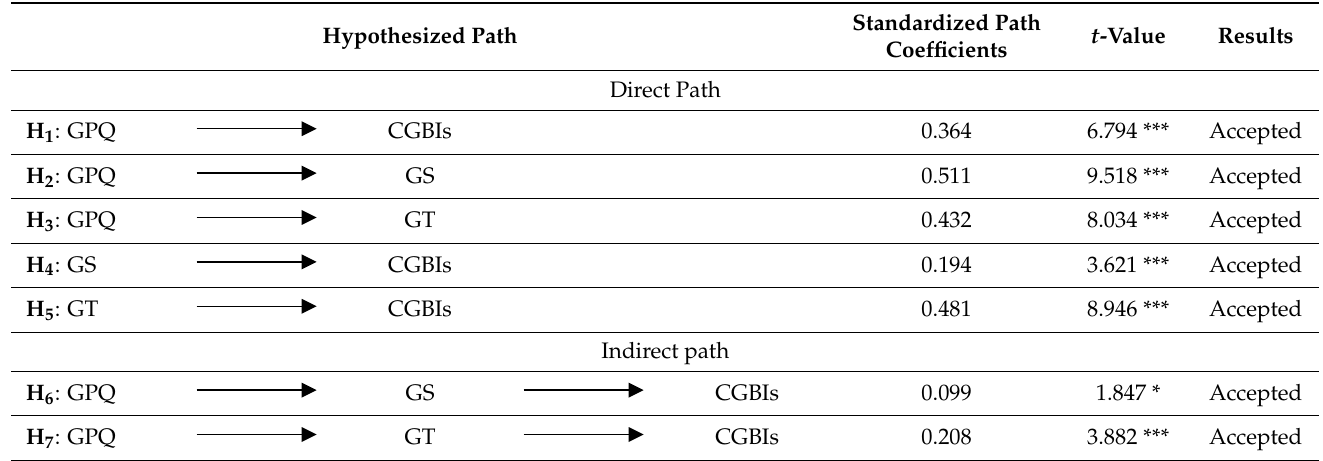
Table 5. Structural Parameter Estimates.